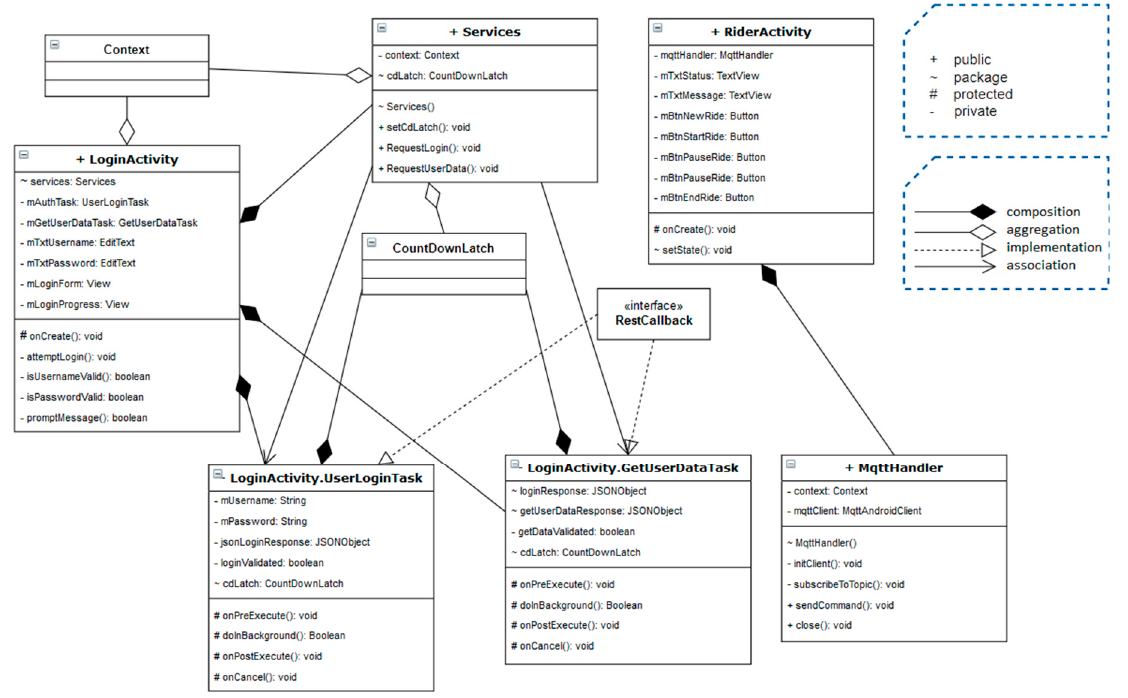
Figure 12. UML class diagram in Android application.